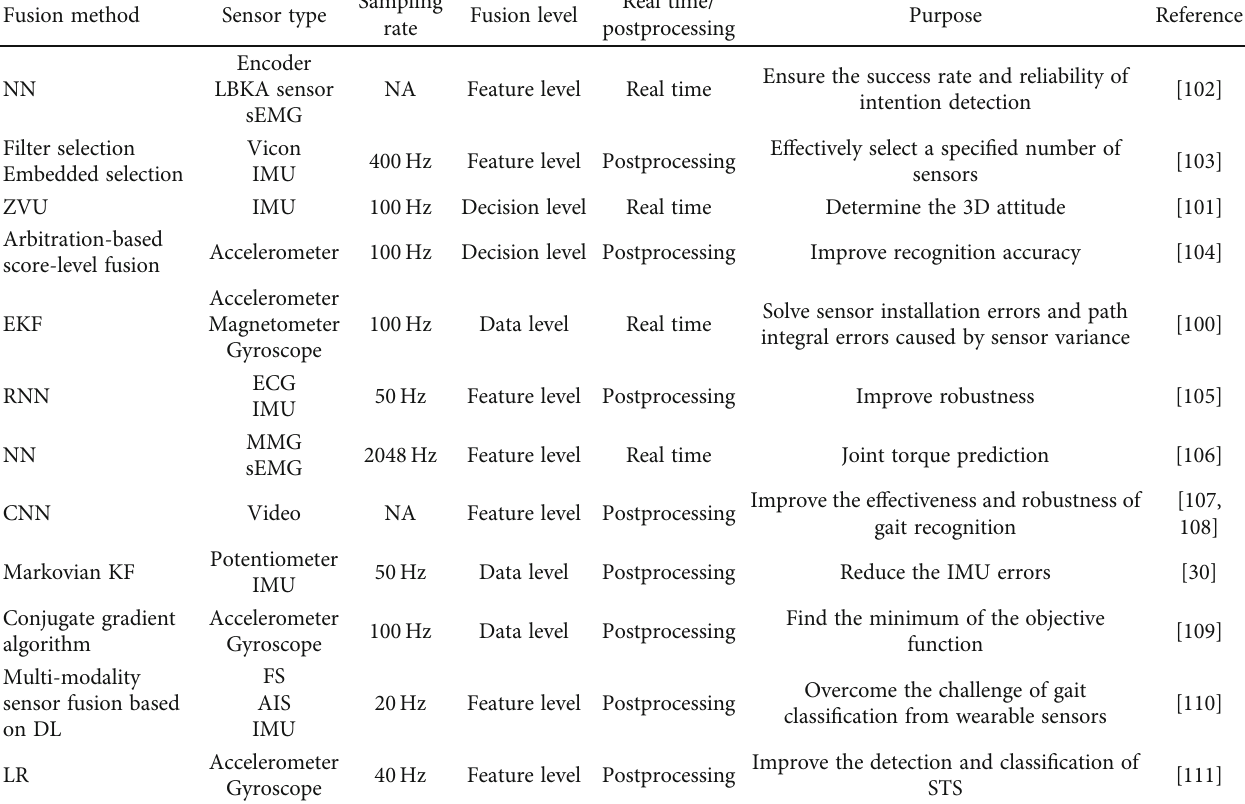
Table 3: Fusion of multiple information sensors for